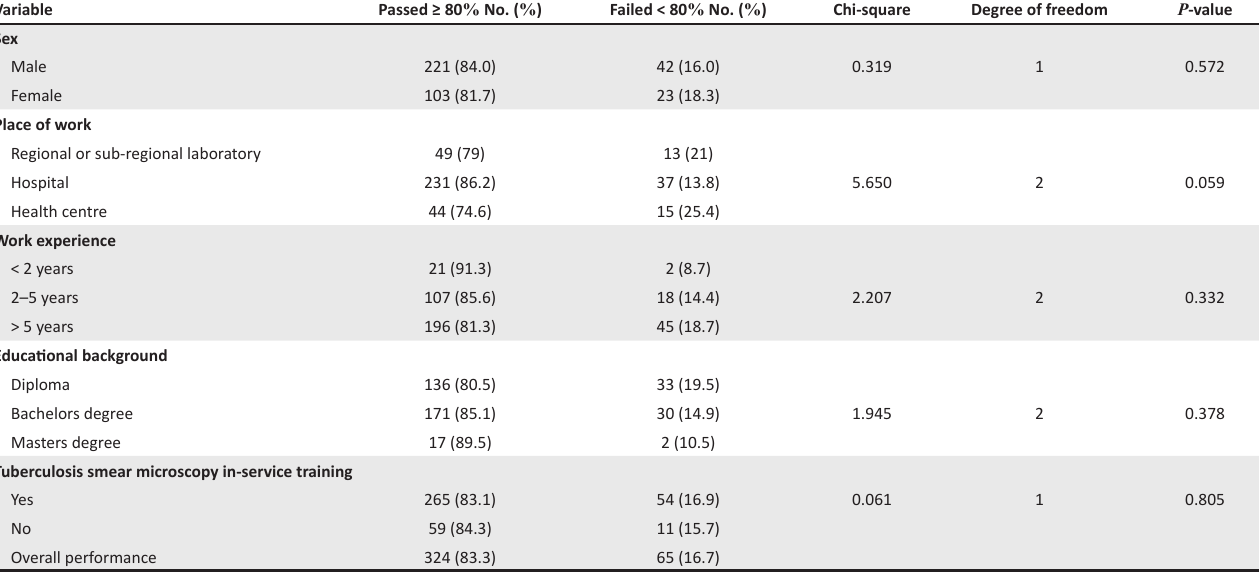
TABLE 3: Relationship between demographic characteristics and scores of microscopists at tuberculosis external quality assessment rechecking laboratories in Ethiopia ( N = 389), April–July, 2015.